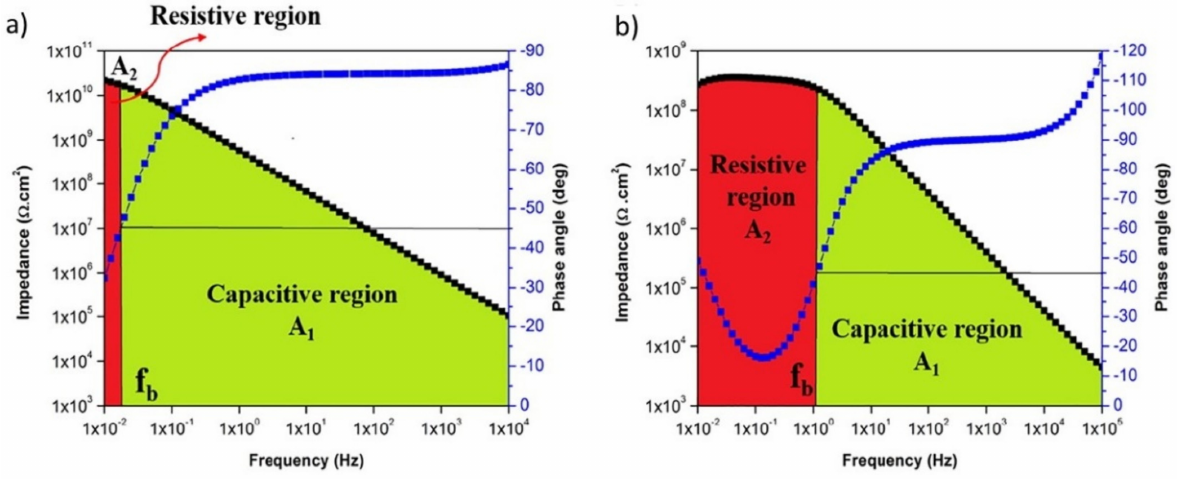
Figure 6. Representative Bode plots of an epoxy–polydimethylsiloxane (ES0) coating after ( a ) 1 day and ( b ) 30 days of immersion, along with the determination of the breakpoint frequency and the cor- responding capacitive (A1) and resistive (A2) regions. Reproduced with permission of Elsevier